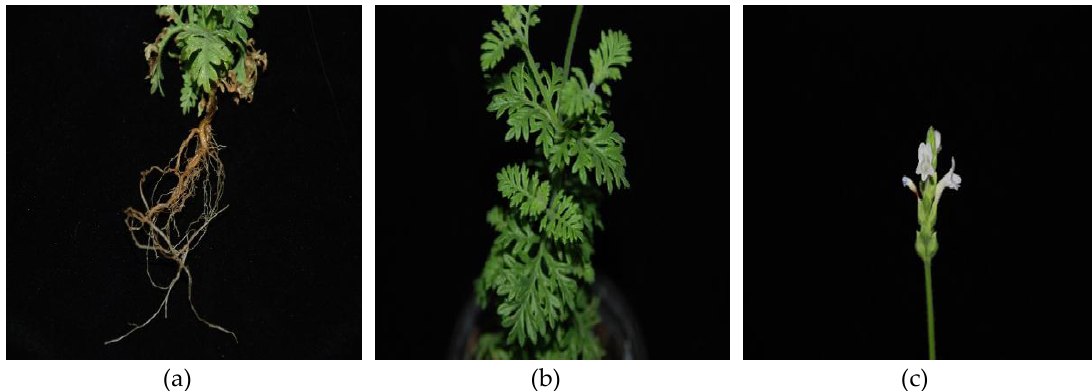
Figure 1. Photographs of the root ( a ), leaf and stem ( b ), and flower ( c ) of Lavandula pubescens